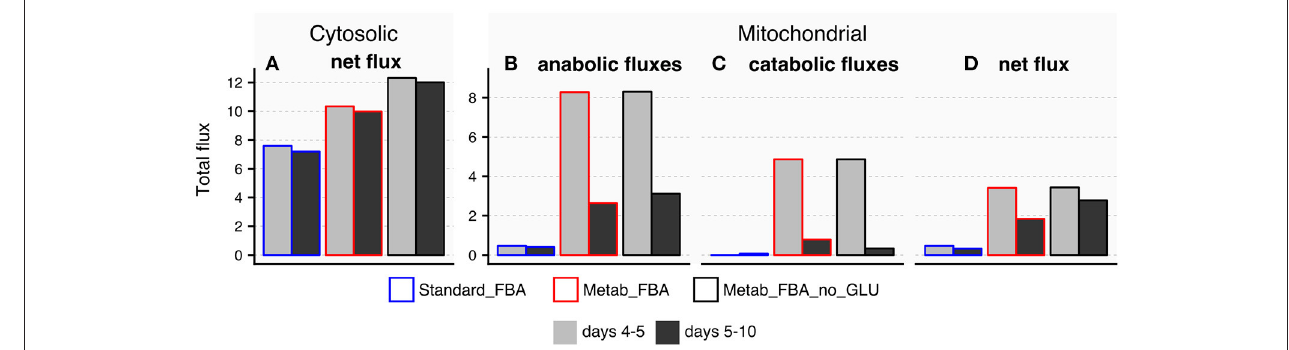
FIGURE 8 | Predicted exchange fluxes for glutamate inside the mitochondria and cytosol by three different FBA models. All comparisons refer to reactions that connect glutamate to the TCA cycle in days 4–5 or days 5–10 FEM samples using three different FBA models: Metab_FBA, which includes information for all measured metabolites; Metab_FBA_no_GLU, which includes information for all measured metabolites except for glutamate; and Standard_FBA, which does not include metabolite measurement information. (A) Difference between cytosolic consumption and production. (B) Fluxes that produce glutamate within the mitochondria (C) Fluxes that consume glutamate inside the mitochondria (D) Difference between mitochondrial production and consumption per day per model. All data is available in Supplementary Table 11